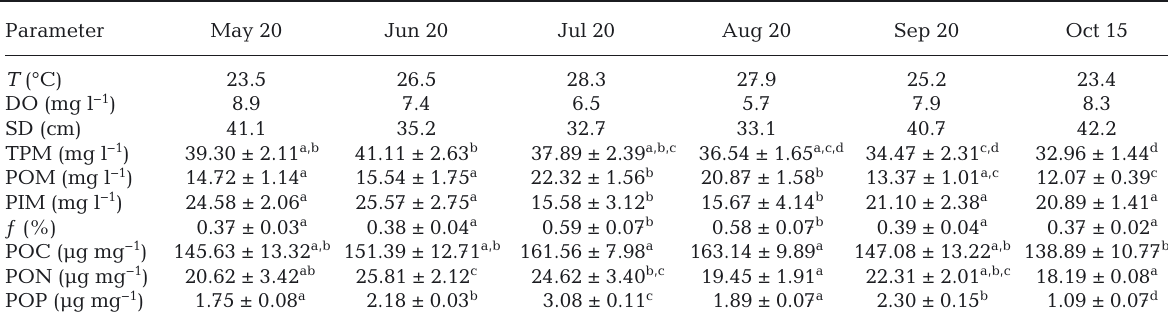
Table 1. Temporal changes in environmental conditions ( T , temperature; DO, dissolved oxygen; SD, transparency), food con- ditions (TPM, total particulate matter; POM, particulate organic matter; PIM, particulate inorganic matter; ƒ, organic content) and nutrient content of suspended particulate matter (POC, particulate organic carbon; PON, particulate organic nitrogen; POP, particulate organic phosphorus). With the exceptions of T , DO and SD, data are presented as means ± 1 SD (n = 8−9). Different superscript letters within a row indicate a significant difference between monthly sampling dates in 2011 (p <